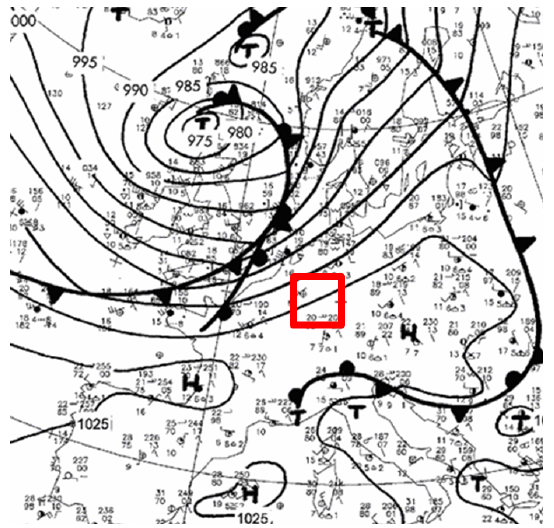
Figure 4. Surface pressure chart provided by the German Weather Service (DWD) over Europe on 6 September 2011, 12:00UTC. The red box indicates the measurement